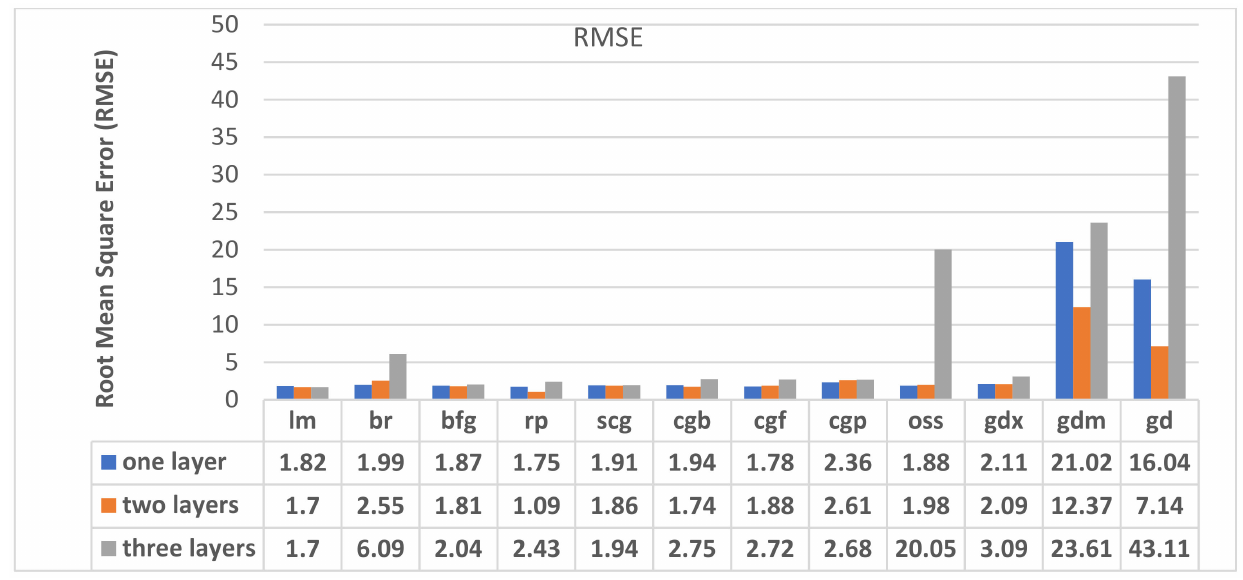
Figure 8. Root Mean Error performance statistics with one, two and three layers of